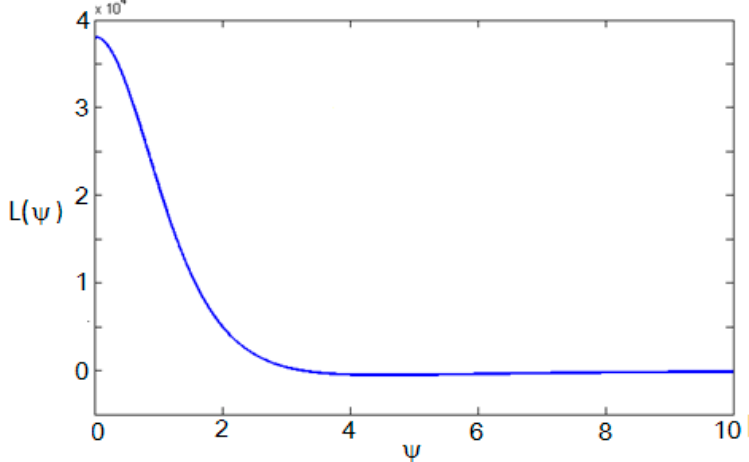
Figure 1. Integral kernel L (for the mean satellite attitude 250 km).